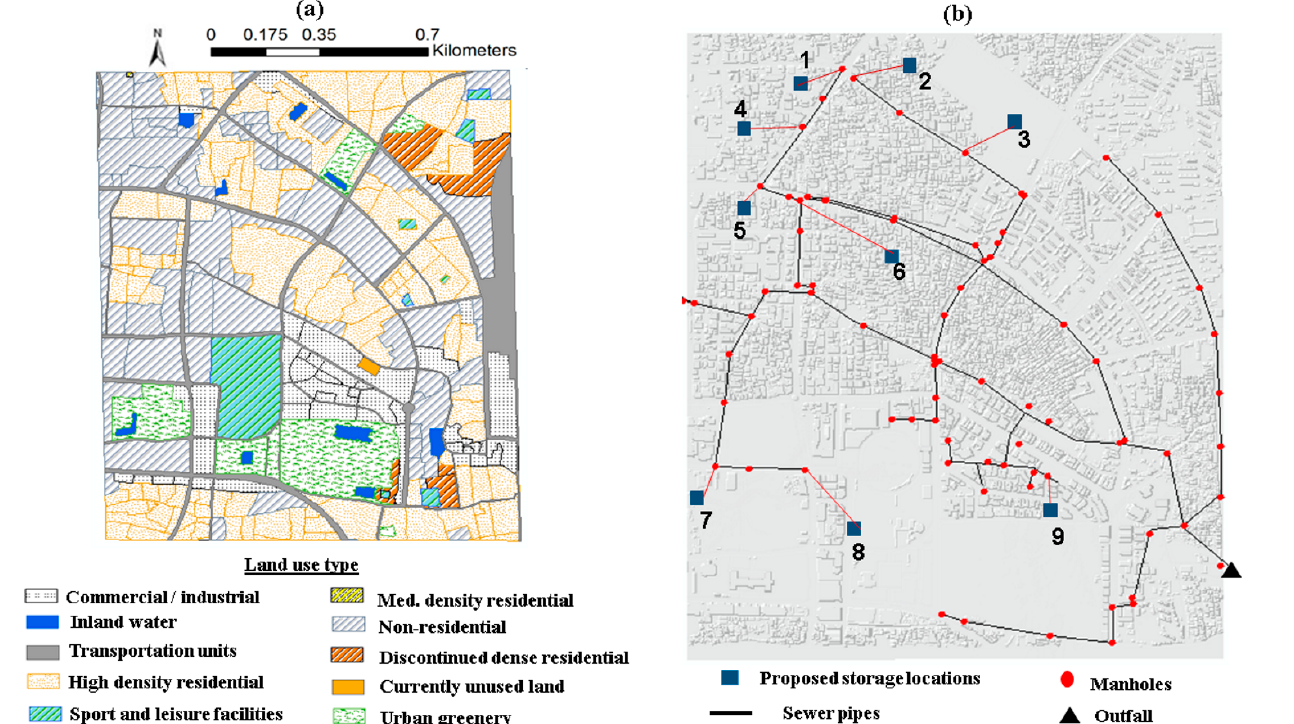
Figure 1. Segunbagicha urban catchment, Dhaka: ( a ) land use type and ( b ) drainage layout.